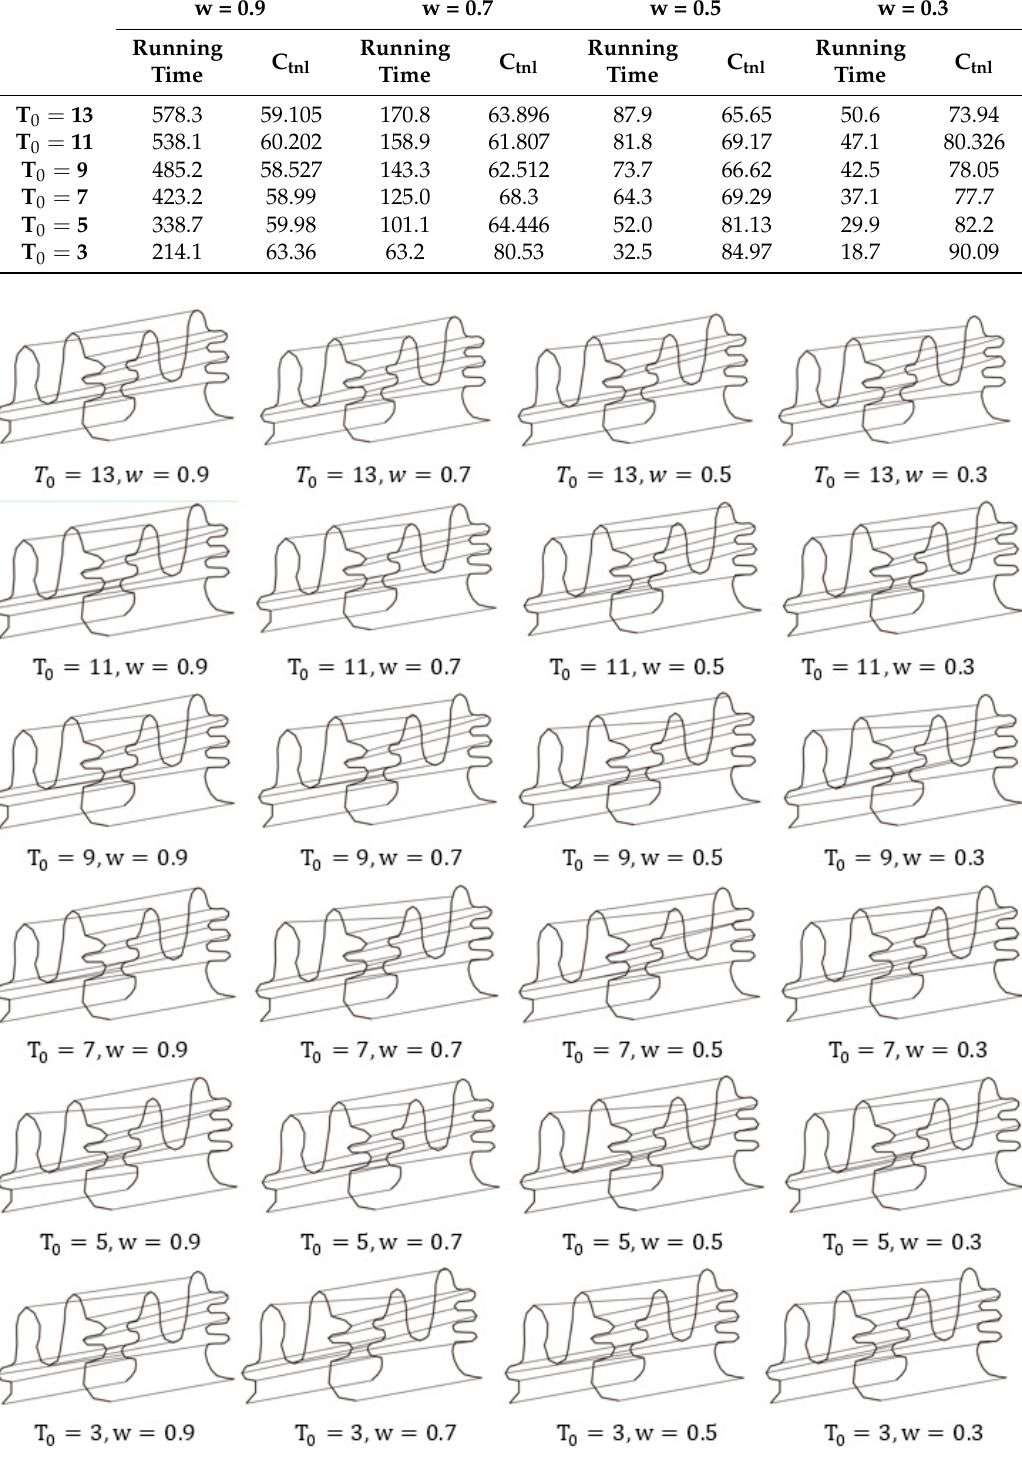
Figure 4. Characteristic corresponding links for different annealing speeds and initial temperatures .